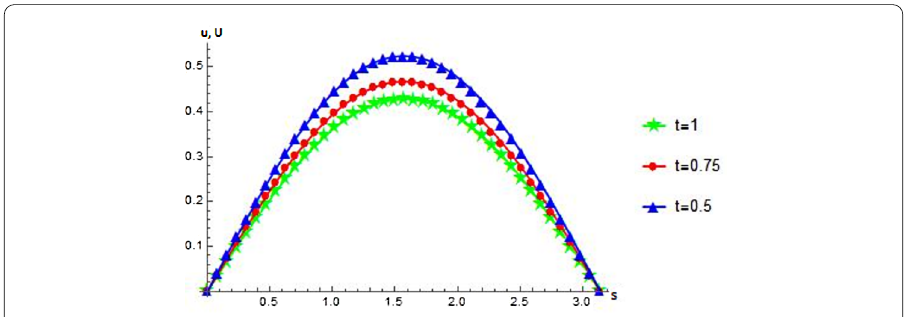
Figure 1 The exact (lines) and numerical (rectangles, stars, bullets) solutions for Example 1 when τ = 0.01, h =